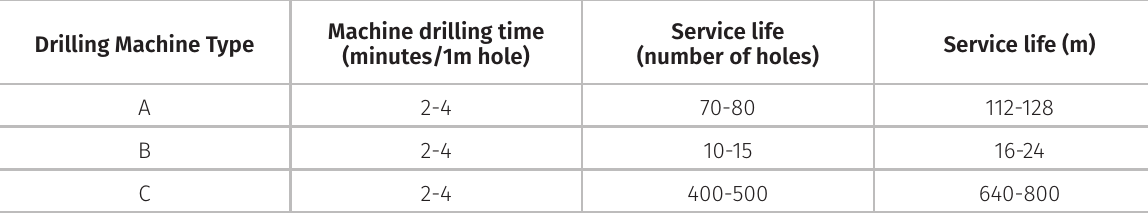
Table VI . Data belonging to drilling machine in the field. Drilling Machine